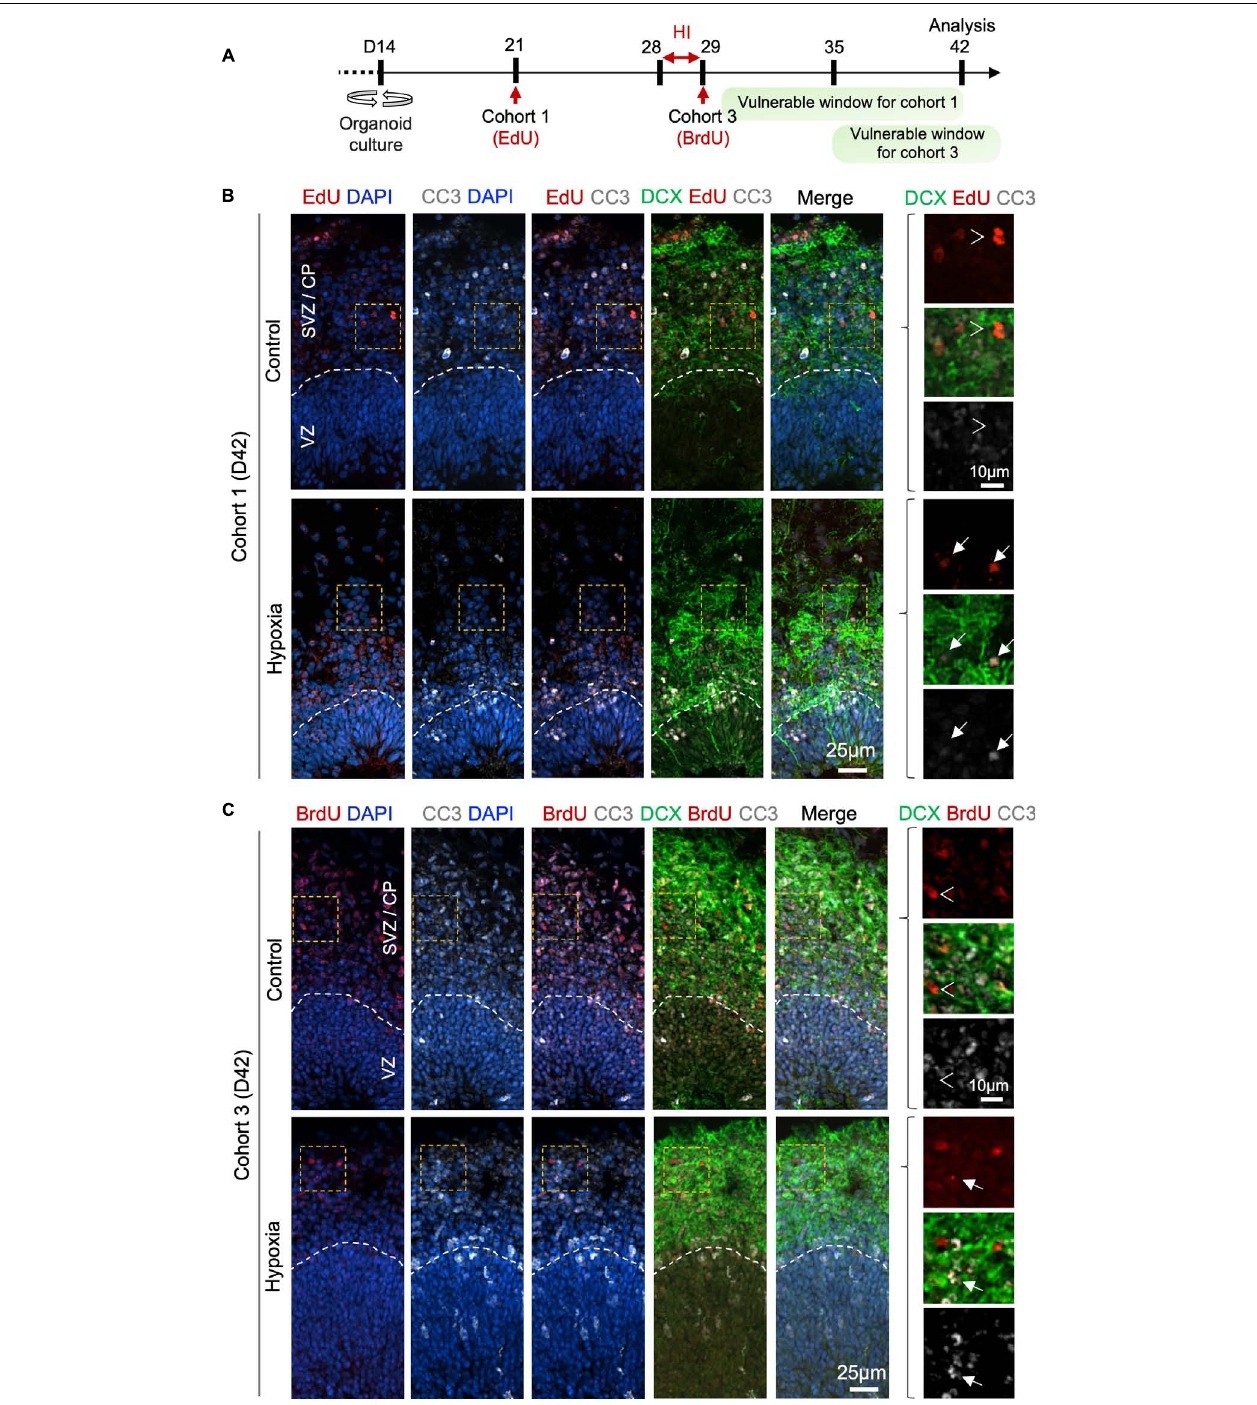
FIGURE 6 | Prolonged effect of transient HI on survival of differentiating population in SVZ. (A) Timeline of experimental paradigm to analyze isochronic cohort 1 and 3, birth-dated at D21 or D29 by 30 min EdU or BrdU pulse, respectively, and analyzed at D42 (14 dpi). The vulnerable windows for each cohort are depicted as green bars. (B,C) Representative IF images for CC3 and DCX in D42 cerebral organoids. Dashed white lines demarcate VZ and SVZ/CP layers. (B) For cohort 1 cells birth-dated at D21 (1 week before HI) and analyzed at D42 (14 dpi), colocalization of EdU, CC3, and DCX staining was observed in HI condition (white arrows), but rarely in control (white arrowheads point to no overlap). (C) For cohort 3 cells birth-dated at D29 and analyzed at D42 (14 dpi), no colocalization of BrdU, CC3 and DCX staining was observed in control (white arrowheads), but after HI, apoptotic LRCs with remnant of colocalized DCX and BrdU immunosignals were observed (white arrows). Enlarged images of area outlined by dashed orange box are shown on the right.